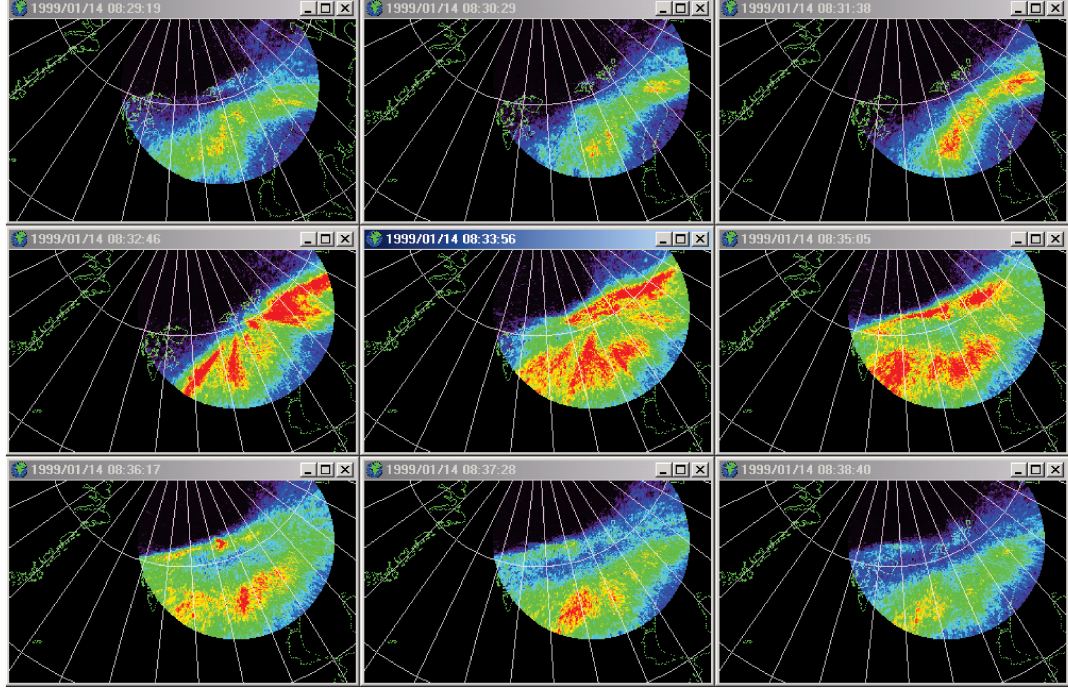
Fig. 6. Heiss Island all-sky camera images at 630.0nm taken at 08:29:19; 08:30:29; 08:31:38; 08:32:46; 08:33:56; 08:35:05; 08:36:17; 08:37:28; and 08:38:40UT, projected to an altitude of 250km and shown on the background of a geographic coordinate system. Same format as in Fig.